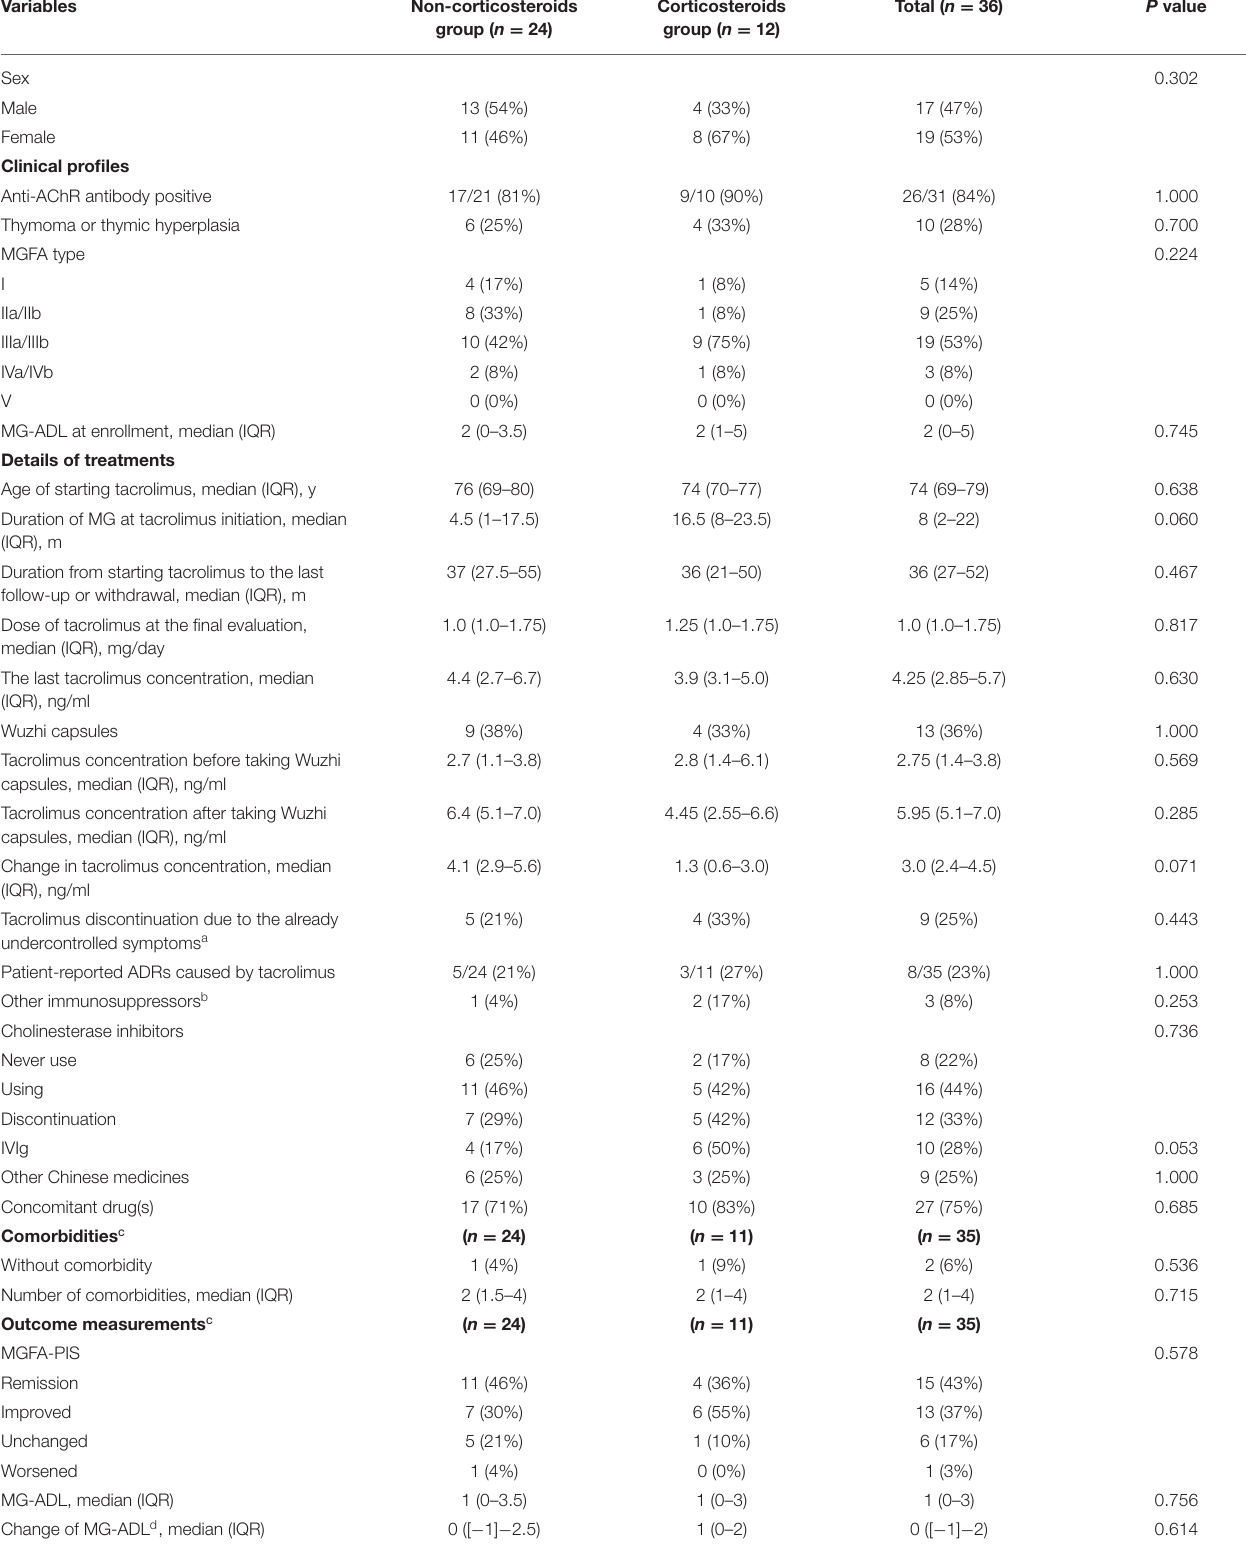
TABLE 2 | Clinical profiles and outcome measurements of VLOMG patients in the Tac group.